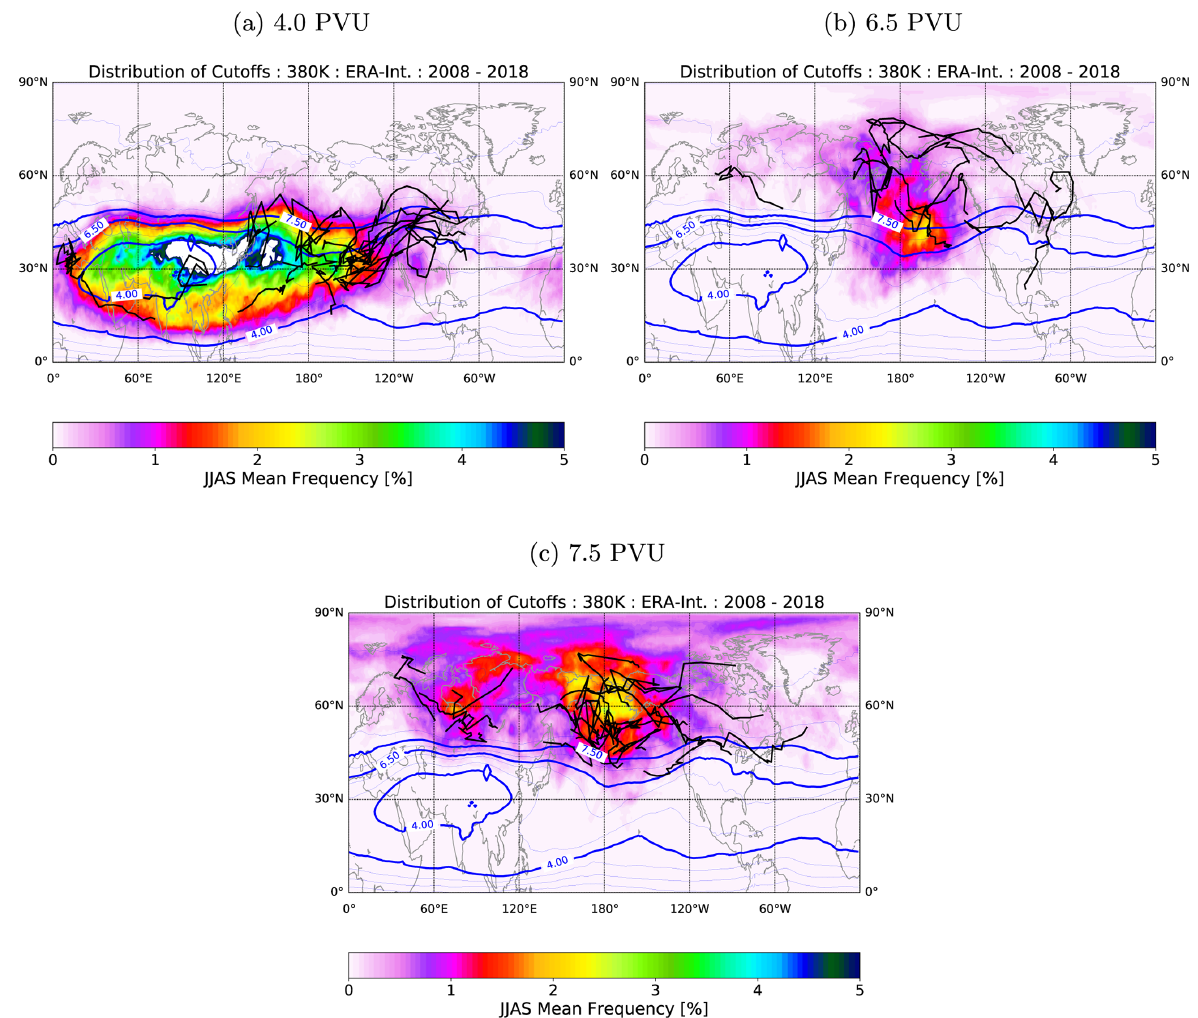
Figure 5. Climatological frequency of ASMA-related cutoffs during JJAS, for (a) 4.0PVU cutoffs, (b) 6.5PVU cutoffs, and (c) 7.5PVU cutoffs. The blue lines indicate particular PV contours. A subset of the identified tracks with a lifetime of at least 4d is plotted with black lines. Here, 1% means that a point is covered with a cutoff in 1% of the time steps in JJAS. Frequencies higher than 5% are coloured